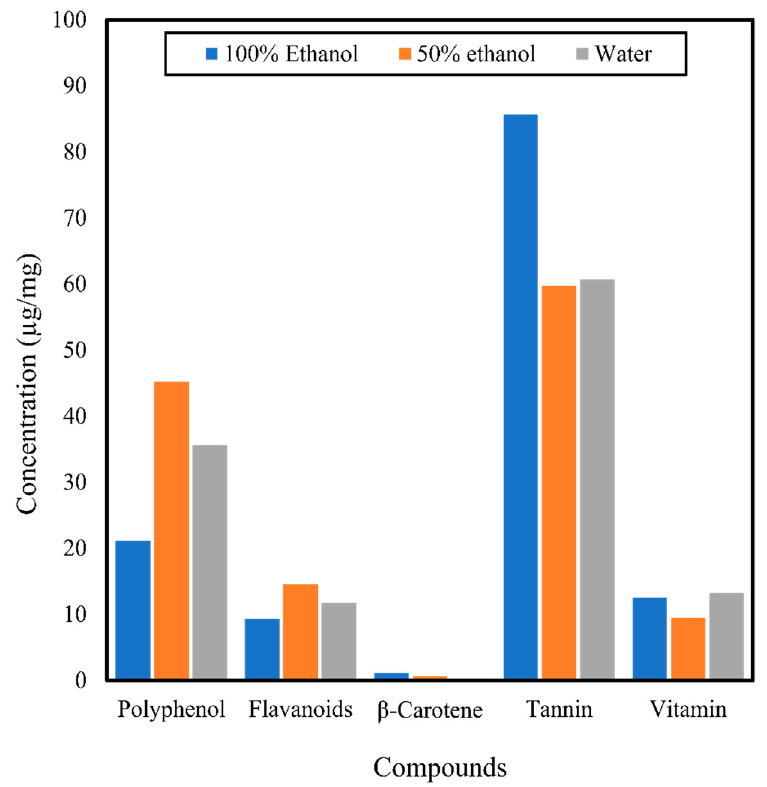
Figure 4. Compounds extracted from Centella asiatica using 100% ethanol, 50% ethanol, and water in the Soxhlet extraction method by Rahman et al.